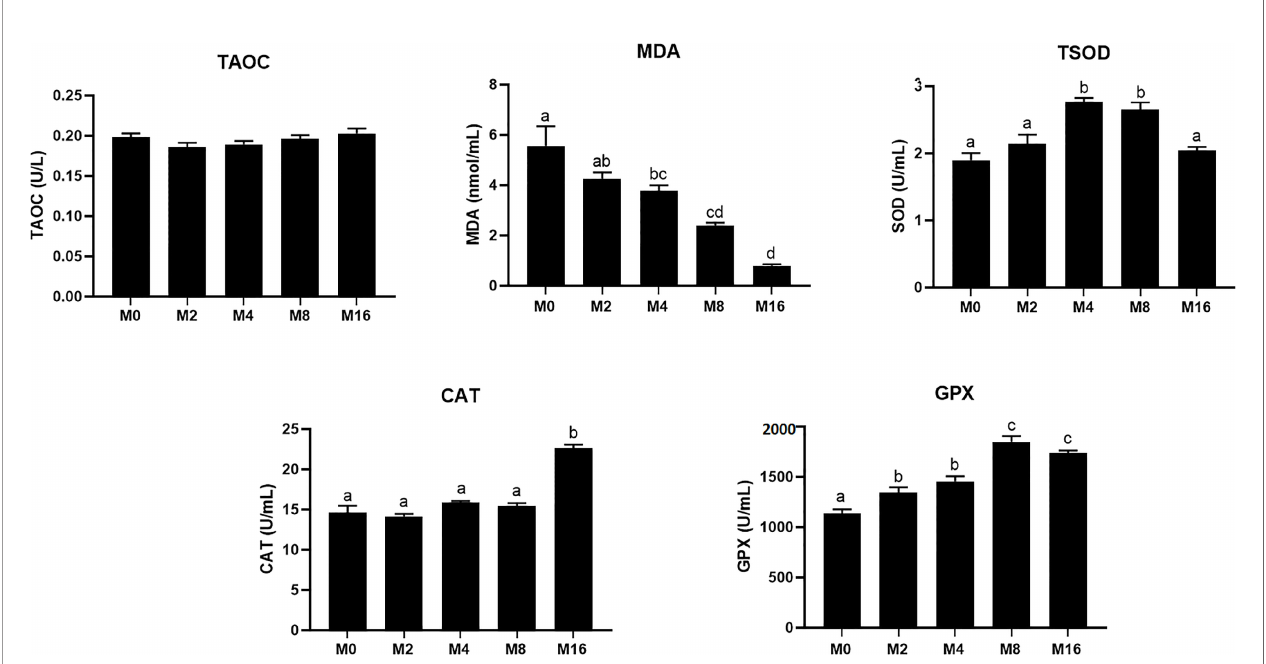
FIGURE 1 | Effects of dietary MOS on antioxidative indices in plasma of Litopenaeus vannamei . a,b,c Value bars not sharing the same superscript letter are signi fi cantly different as evaluated by Tukey ’ s test ( p < 0.05). T-AOC, total anti-oxidation capacity; TSOD, total superoxide dismutase; MDA, malondialdehyde; CAT, catalase; GPX, glutathione peroxidase; MOS, mannan oligosaccharide.